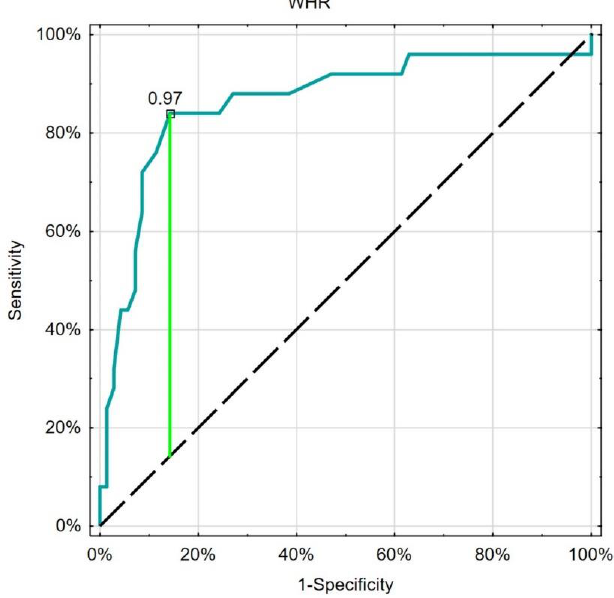
Figure 2. ROC analysis (turquoise line) of WHR in the differentiation between type 1 or type 2 dia- betes, with the best cut-off point based on the Youden index (green line). Black dashed-reference line.